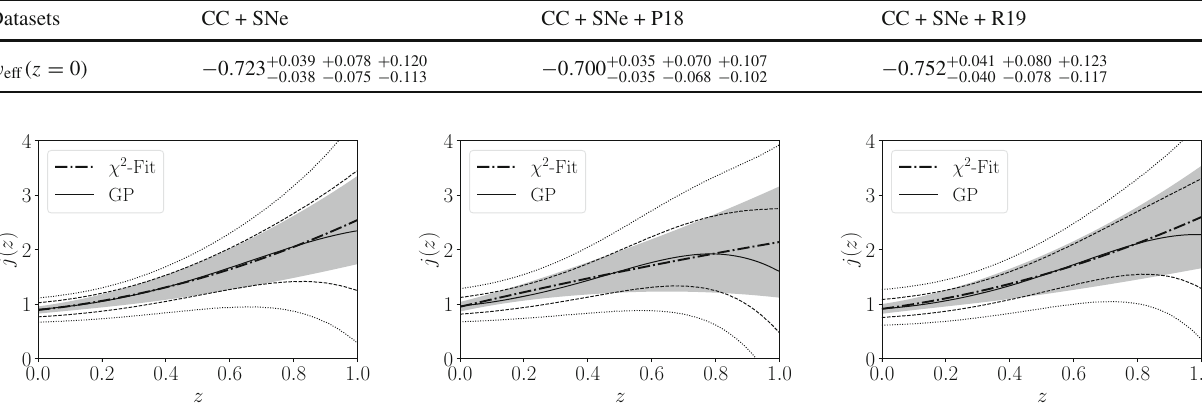
Fig. 13 Plots showing a comparison between the reconstructed jerk j ( z ) and the estimated j fit ( z ) using the combined CC + Pantheon data (left), CC + Pantheon + P18 data (middle) and the CC + Pantheon + R19 data (right). The black solid line is the best fit curve from GP reconstruction. The 1 σ and 2 σ CL are shown in dashed and dotted lines respectively. The bold dot-dashed line represents the best fit function from χ 2 -minimization. The associated 1 σ uncertainty is shown by the shaded region